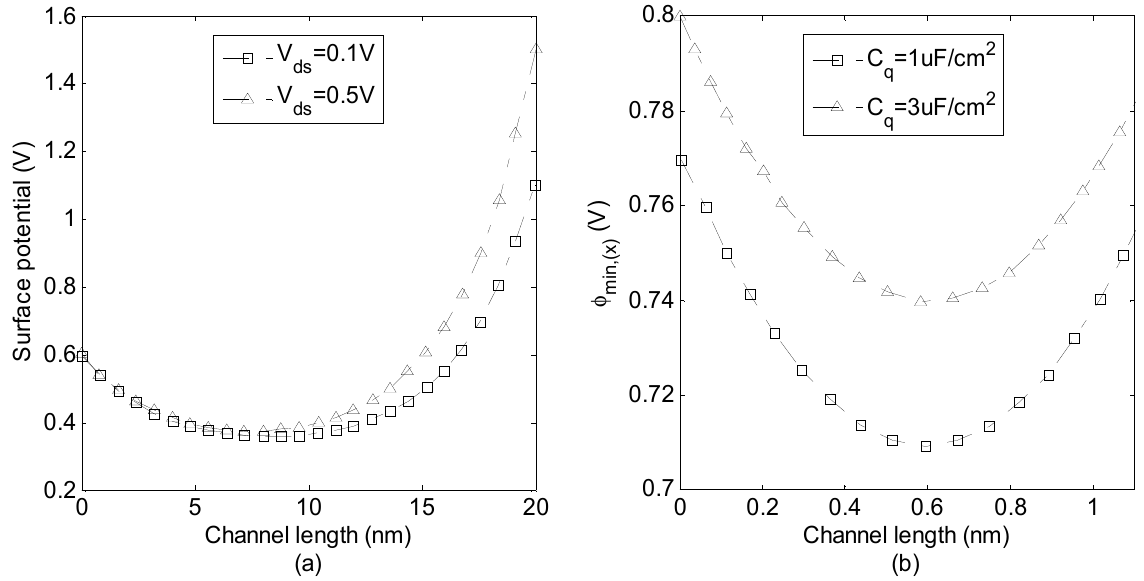
Figure 4. ( a ) Surface potential along the channel distance for unequal flat band/gate voltages of the front and back sides ( V fg = 0.1 V, V bg = 0.2 V, V fb-f = 0.1 V, V fb-b = 0.2 V), ( b ) the minimum potential along the channel for different values of quantum capacitance ( V fg = V bg = 0.4 V). The effect of gate-oxide thickness on threshold voltage versus channel length is illus- trated in Figure 5a. Apparently, threshold voltage increases by increased oxide thickness. This is because of the fact that gate-oxide electric field increases as oxide thickness decreases. The variation of threshold voltage along the channel for different drain–source voltages is plotted in Figure 5b. It can be seen that the threshold voltage reduces as the voltage increases. It is noteworthy that the effect of drain–source voltage is more significant for the source side of the